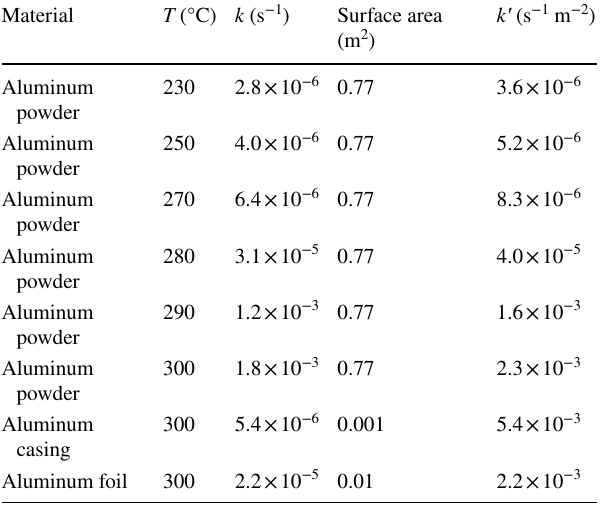
Table 3 Reaction rate constant per unit of surface area for hydrogen production using aluminum ( k is reaction rate constant, and k ′ is reac- tion rate constant per unit of surface area)